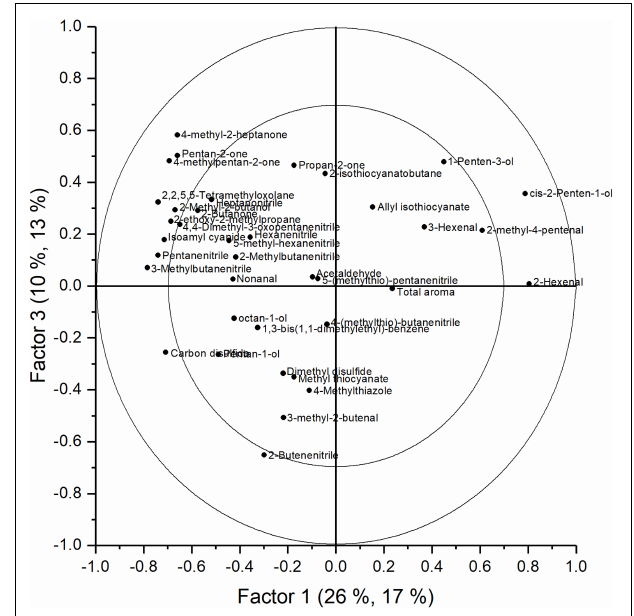
FIGURE 8 | Loadings plot of factor 1 and 2 obtained with the PLS analysis of the aroma measurement of cabbage juices analyzed with SPME-GC-MS.